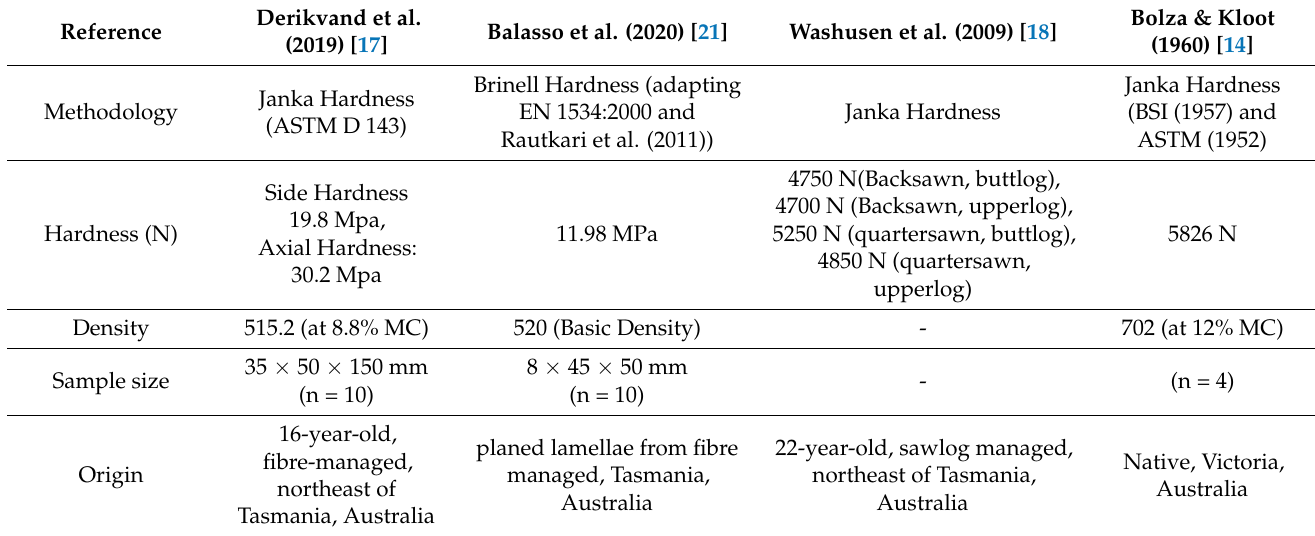
Table 4. Janka hardness comparison of E. nitens (it should be noted that due to the different adaptations of methodology and sample sizes, the values cannot be directly compared to each other) .